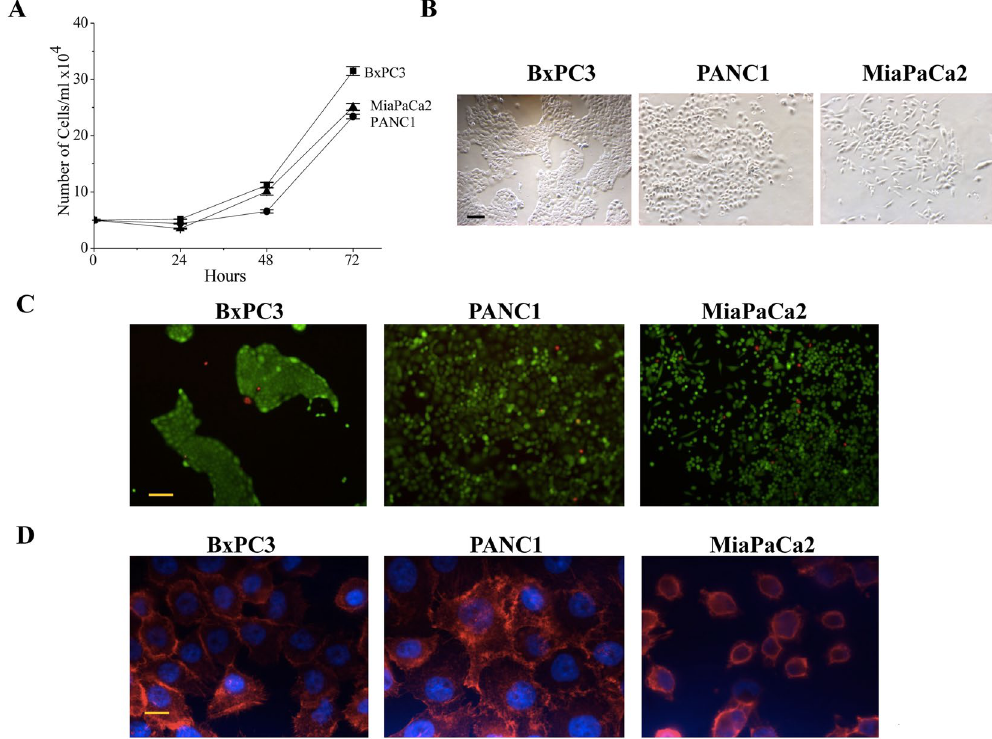
Figure 1. In vitro cell growth characteristics of PDAC cells in 2D culture conditions. (A) Comparison of growth rate among the PDAC cell lines in terms of increase in number of cells per day (n = 3). Data are means ± SEM of three separate experiments each carried out in triplicate. At the 0.05 level, the PANC1, MiaPaCa2 and BxPC3 are not significantly different. (B) Microscopic images after 48 h of culturing of PDAC cell lines. Morphology was different among the cell lines. (C) Live and dead cells were stained by Calcein (Green) and PI (Red) respectively after 24 h of culturing. (D) Actin filaments were stained by rhodamine conjugated Phalloidin (Red) and nucleus was stained by DAPI (Blue). Scale bars in B and C represent 100 µ m, in D represents 10 µ